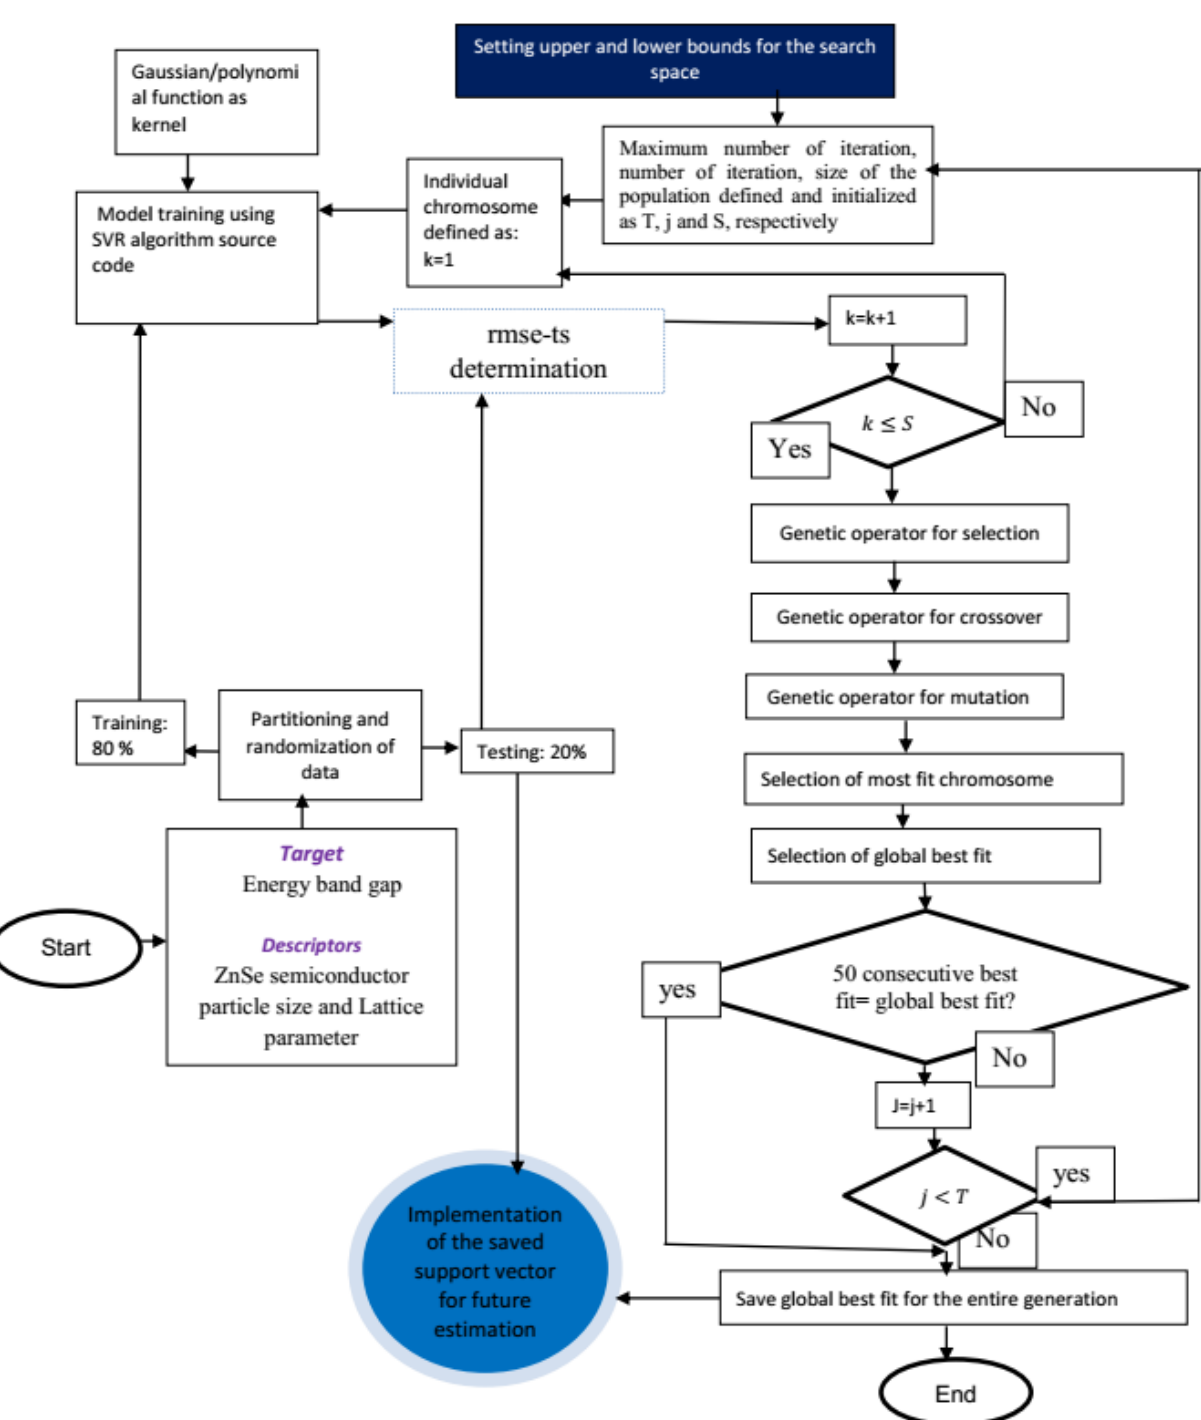
Figure 1. Description of the computational details of the developed hybrid model.